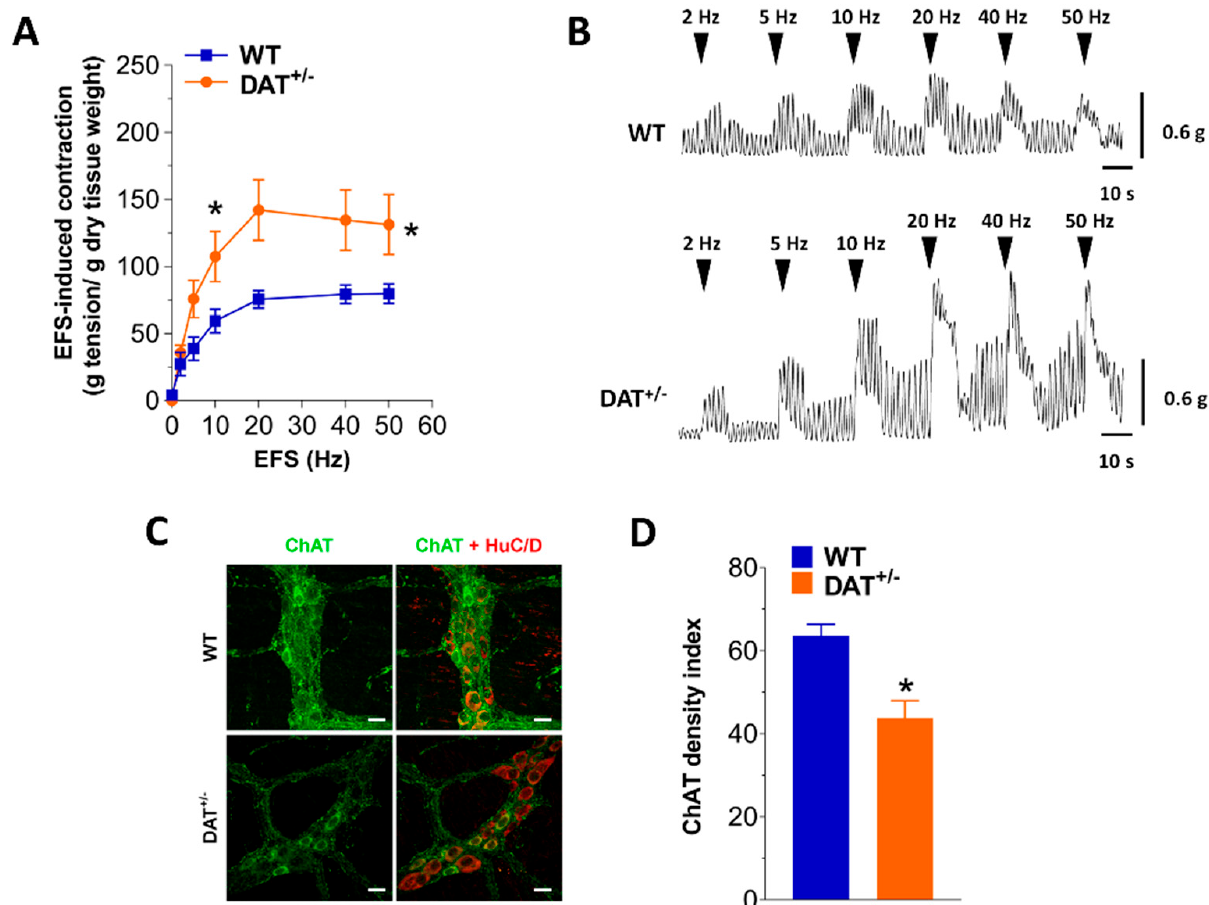
Figure 4. DAT hypofunction influences neuromuscular response. ( A ) Neuromuscular excitatory response induced by EFS (0–50 Hz) in isolated ileal preparations of WT and DAT +/ − mice. ( B ) Representative tracings of responses induced by EFS in WT and DAT +/ − preparations. ( C ) Representative confocal microphotographs showing the distribution of ChAT (green, marker for cholinergic neurons) and HuC/D (red, pan-neuronal marker) and ( D ) ChAT density index in LMMP preparations of WT and DAT +/ − mice. Scale bars = 22 µ m. Data are reported as mean ± SEM. * p < 0.05 vs. WT mice. n = 5 mice/group.